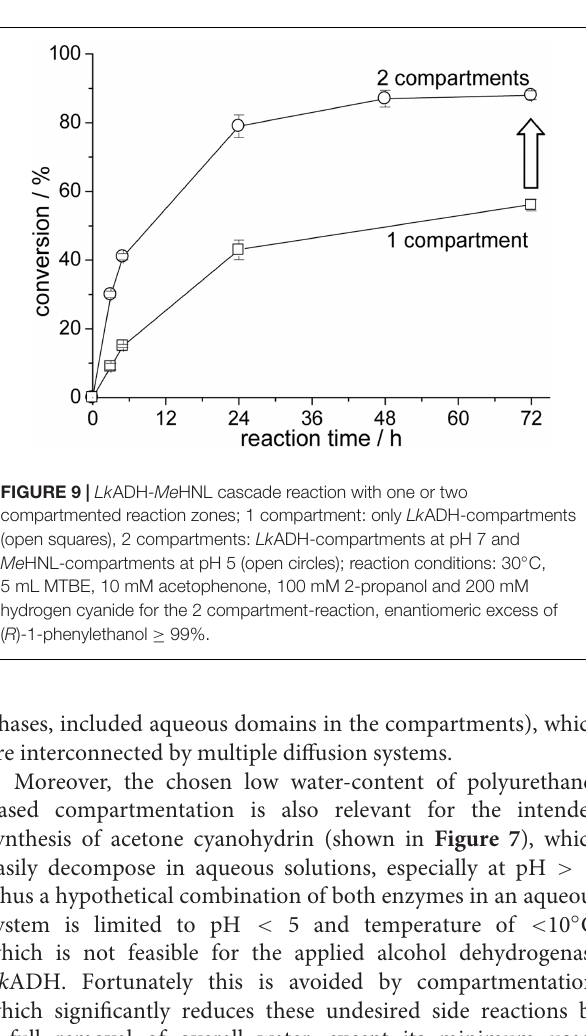
FIGURE 8 | Comparison of the pH dependencies of the investigated alcohol dehydrogenase and hydroxynitrile lyase catalyzed reactions (solubilized, non-immobilized enzymes). Due to the low stability of acetone cyanohydrin the HNL-catalyzed reaction is in theory restricted to pH < 5 (Cooke, 1978).